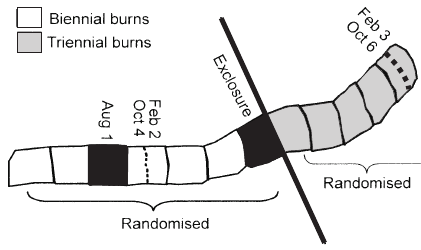
Fig. 2: Each replicate consists of two randomised sections of plots. The first section consists of the fire exclosure, August annual and the five biennial treat- ments. The second, adjoining section consists of the five triennial treatments. The four- and six-year treat- ments (only on the Mopani and Knobthorn/Marula replicates) were created by dividing the February biennial and triennial treatments respectively in